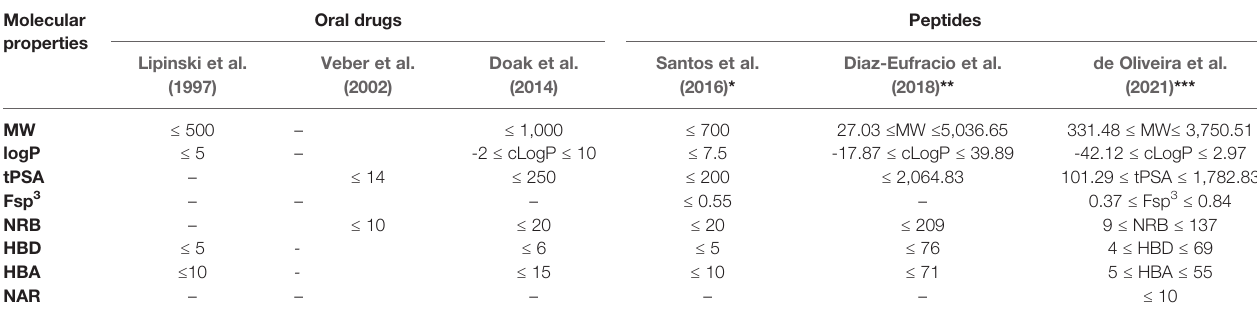
TABLE 1 | Comparison between the chemical spaces and cheminformatic fi lters of peptides and commercial drugs with bioavailability. Molecular